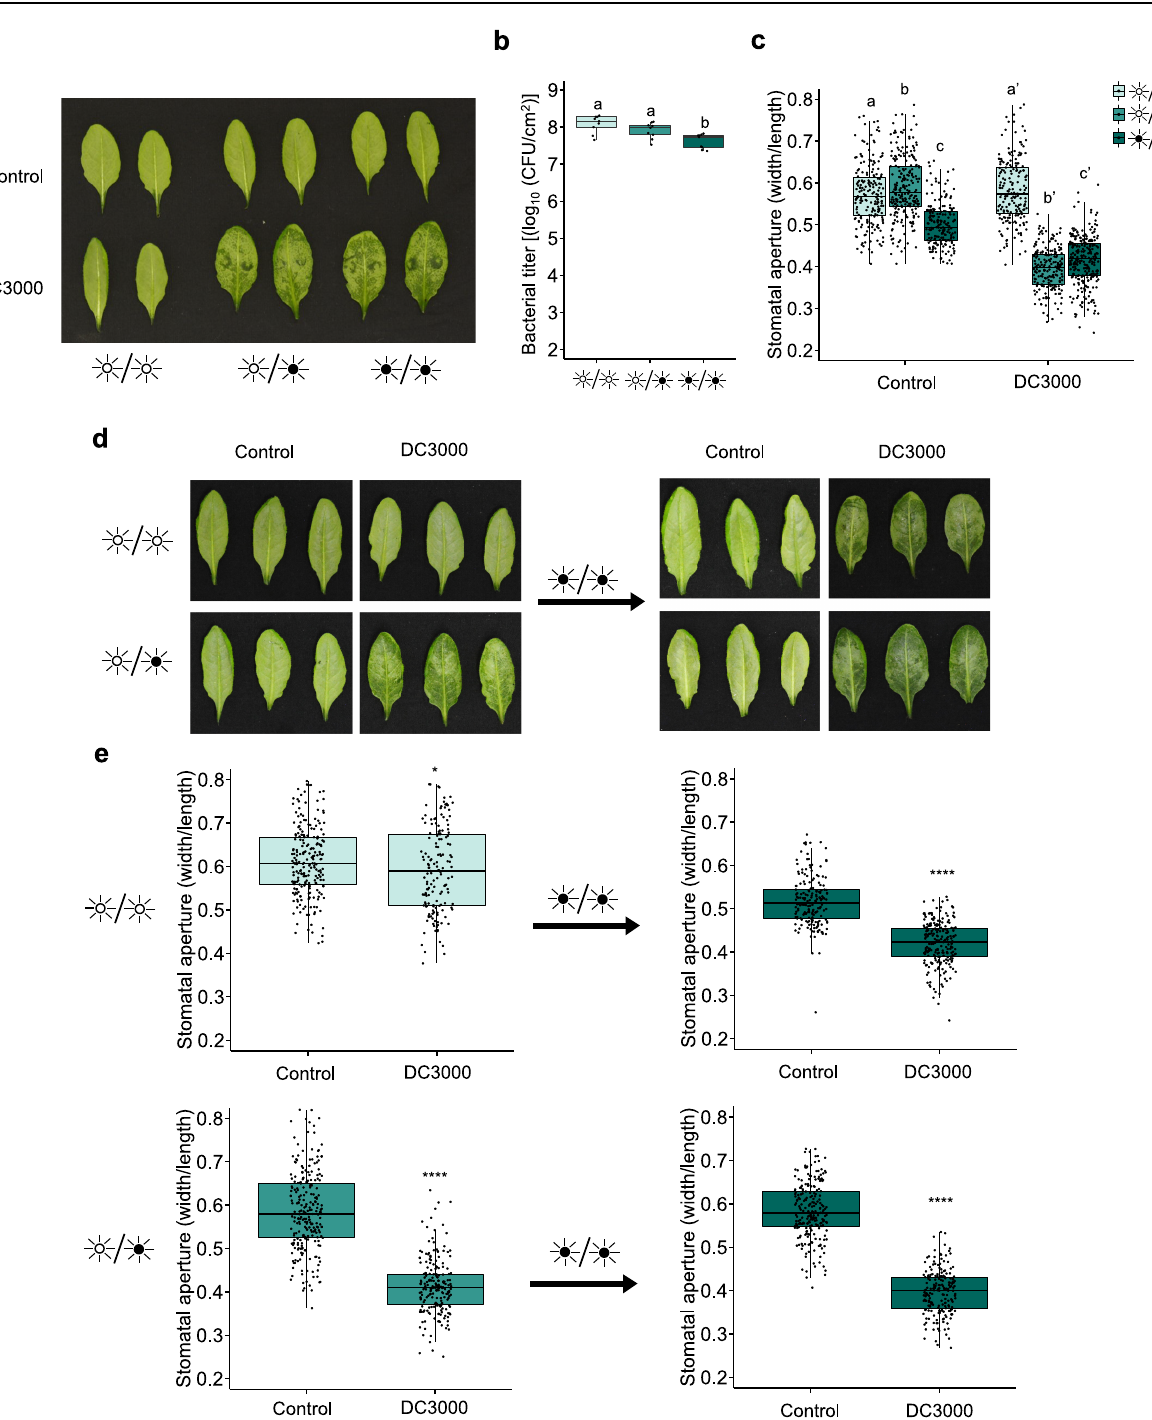
Fig. 2 | Pst requires darkness to induce stomatal closure and water-soaking. a Water-soaking phenotypes in Arabidopsis leaves syringe-in fi ltrated with Pst DC3000 (1×10 8 CFU/ml) at 24 hours post-infection (hpi) under LL, LD or DD conditions. b Bacterial titers from plants described in a ( n =3 biologically inde- pendentreplicates). c Stomatalaperturemeasurementsinplantsdescribedin a by epi fl uorescencemicroscopy( n =194stomataforLLControl, n =190stomataforLL DC3000, n =229 stomata for LD Control, n =196 stomata for LD DC3000, n =185stomataforDDControl, n =262stomataforDDDC3000). d Water-soaking phenotypes in Arabidopsis leaves that were syringe-in fi ltrated with Pst DC3000 (1×10 8 CFU/ml) at 24 hpi under LL or LD conditions (left panel) and in plants treated in the same way followed by transferred to DD for 6h (right panel). e Stomatalaperturemeasurementsfromleavestreatedasin d ( n =220stomatafor